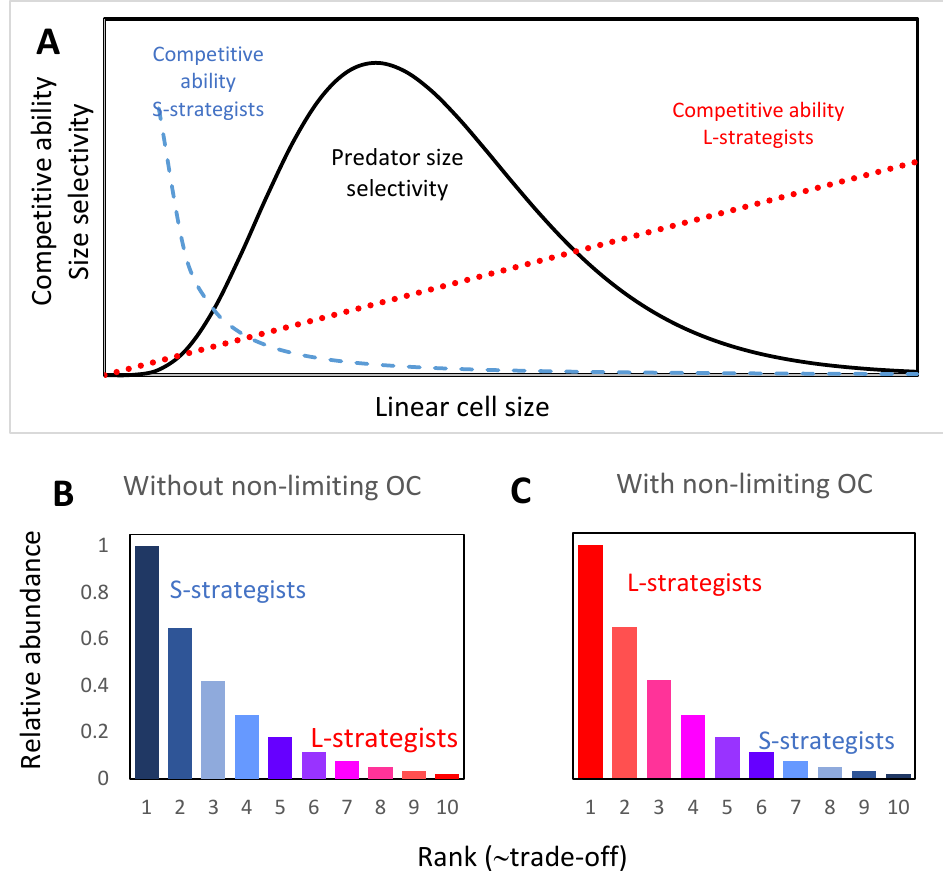
Figure 1. ( A ) Schematic illustration of the proposed mechanism whereby S- and L-strategists decrease the trade-off between competition and defense by reducing or increasing size, respectively. The size-increase of L-strategists requires access to sufficient non-limiting organic C (OC). For S-strategists, competitive ability is assumed to scale with r − 2 . With a size below the peak in prey selectivity, a further decrease in size will increase competitiveness and simultaneously reduce predator loss. For L-strategists where competitiveness scales with r 1 , a reduction in trade-off is obtained if size increases above the peak in predator selectivity. With rank (in abundance) dependent on trade-off, the usually ( B ) S-dominated (blue) rank-abundance curves shift to ( C ) L-dominated (red) in environments with sufficient non-limiting OC.